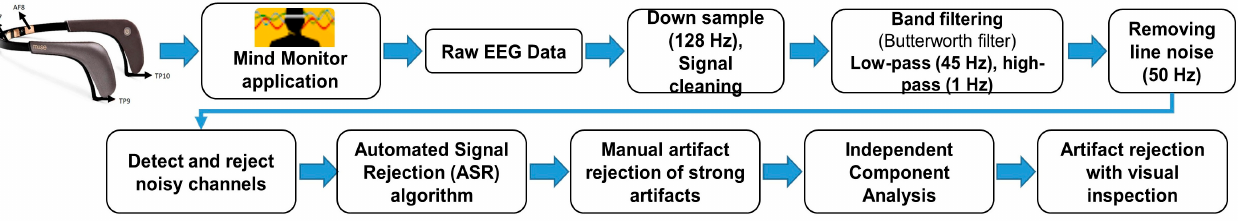
Figure 4. Schematic Illustration of data pre-processing for artifact removal and signal denoising.